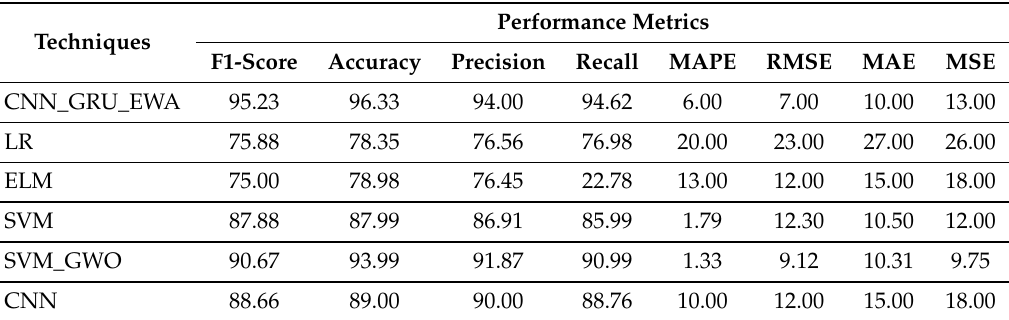
Table 3. Performance evaluation results of proposed and benchmark